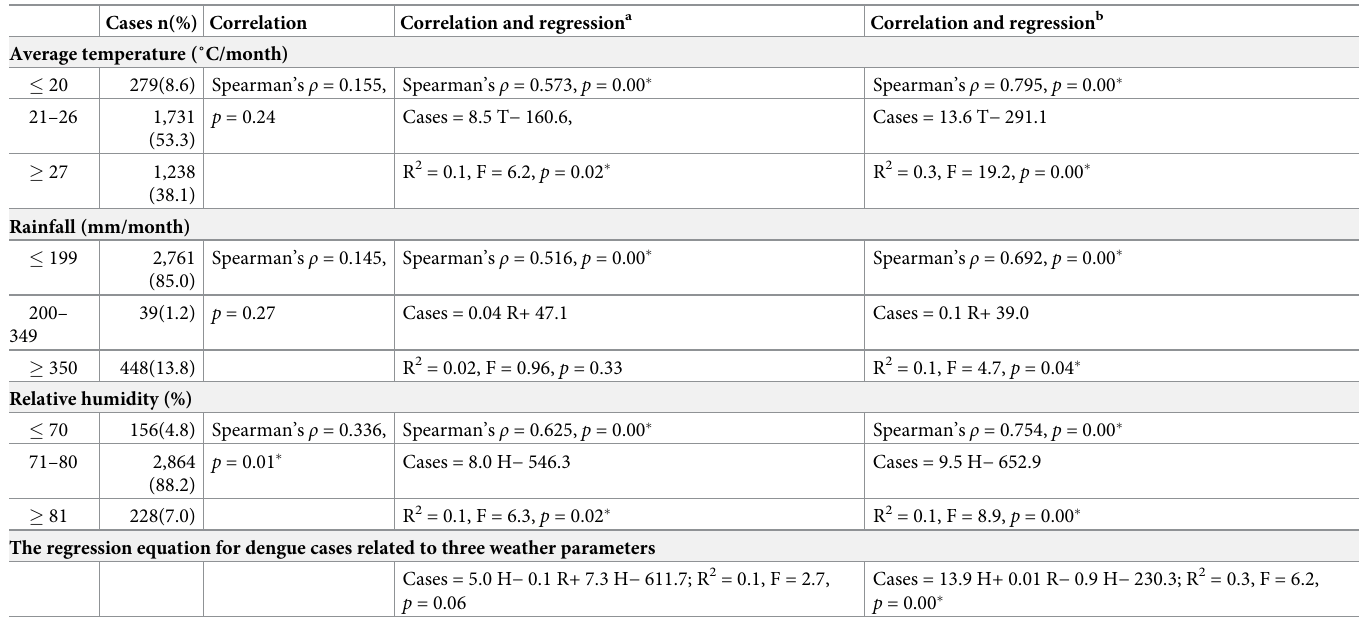
Table 7. Climatic characteristics for autochthonous dengue-infected patients (n = 3,248) and statistical analysis between them. Cases n(%) Correlation Correlation and regression a Correlation and regression b